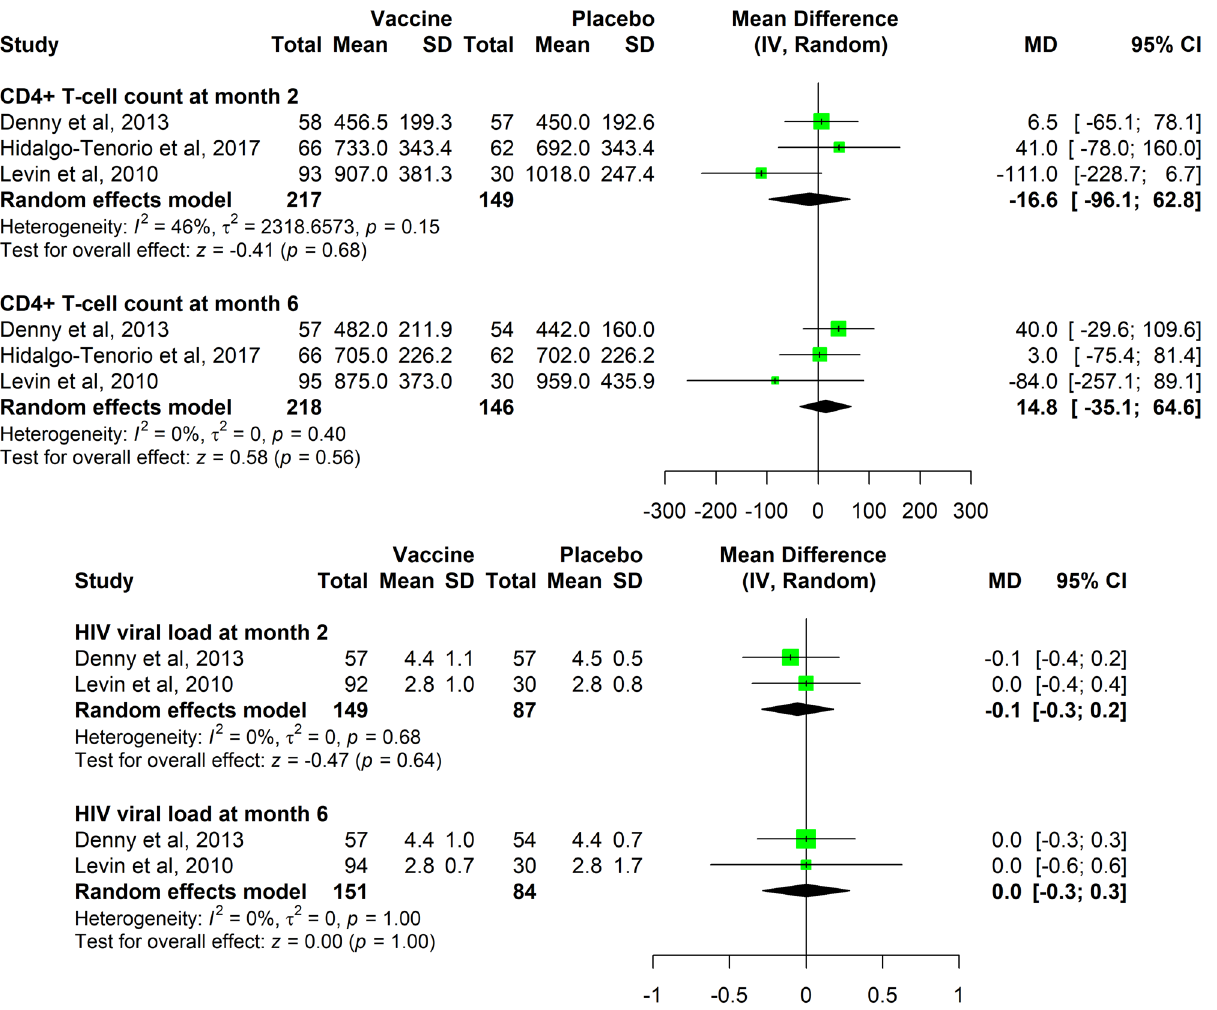
Figure 5. Data synthesis for CD4 cell count and HIV viral load